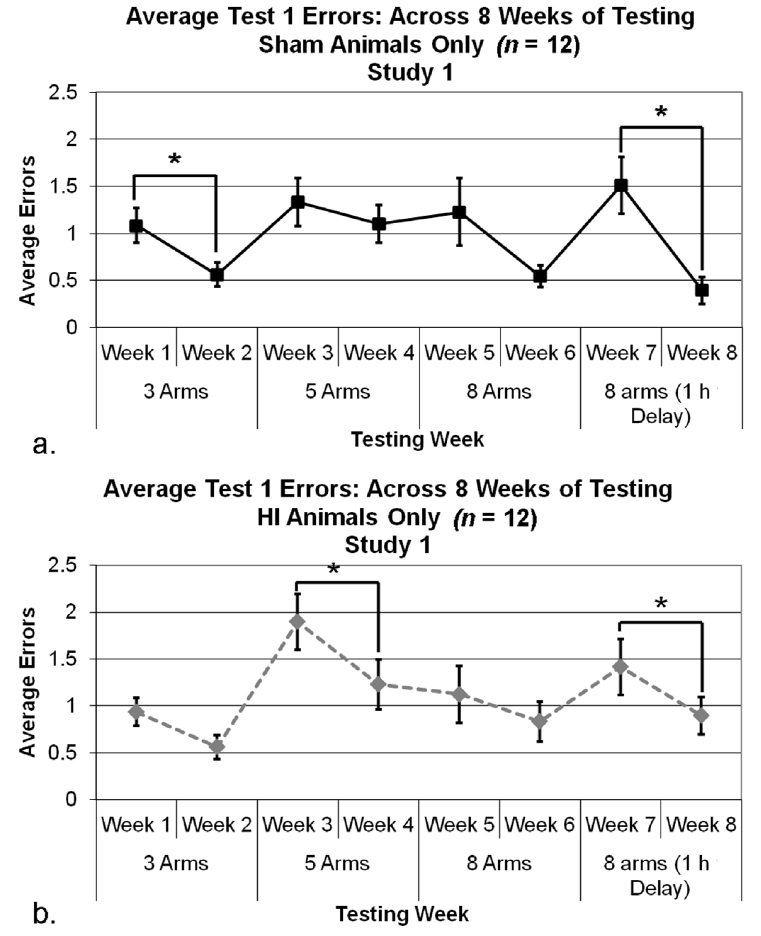
Figure 3. ( a ) A repeated measures ANOVA assessing Trial 1 errors in each Condition revealed a significant effect of Week in Condition 1 (* p < 0.05) and Condition 4 (* p < 0.05), indicating less errors made on the second Week of a Condition. ( b ) A similar analysis was done with HI animals and revealed a significant effect of Week in Condition 2 (* p < 0.05) and Condition 4 (* p < 0.05), indicated less errors (and evidence of learning) on the second week of a